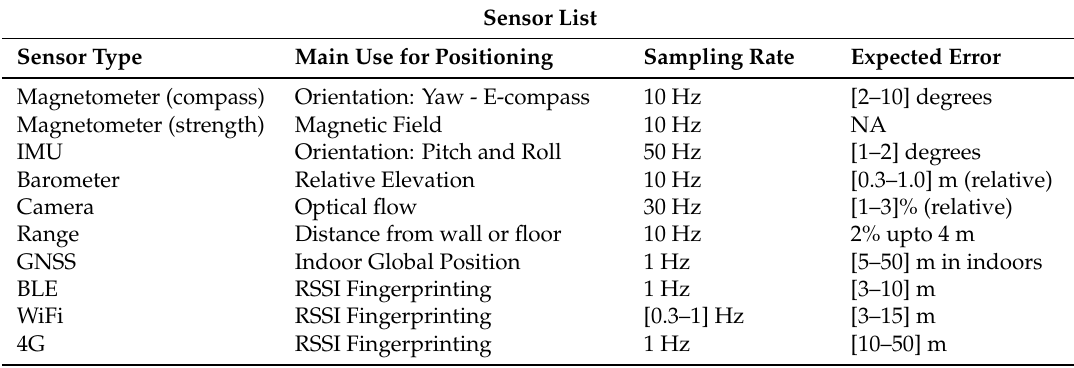
Figure 1. The general structure of the STEPS indoor positioning system ( IPS ) is composed of four layers: sensors (physical, smartphone based); virtual sensors, which can be thought of as dedicated- purpose conceptual sensors based on sensor fusion; algorithms (positioning, state estimation, mapping); and output, the last layer, required for continuance positioning (1–30 Hz), as well as for accuracy, confidence estimation, and event-based reporting, such as floor change. Table 1. Sensors for indoor positioning which are common in smartphones. The data was taken from several popular smartphones such as Samsung’s Galaxy S7, S8 and